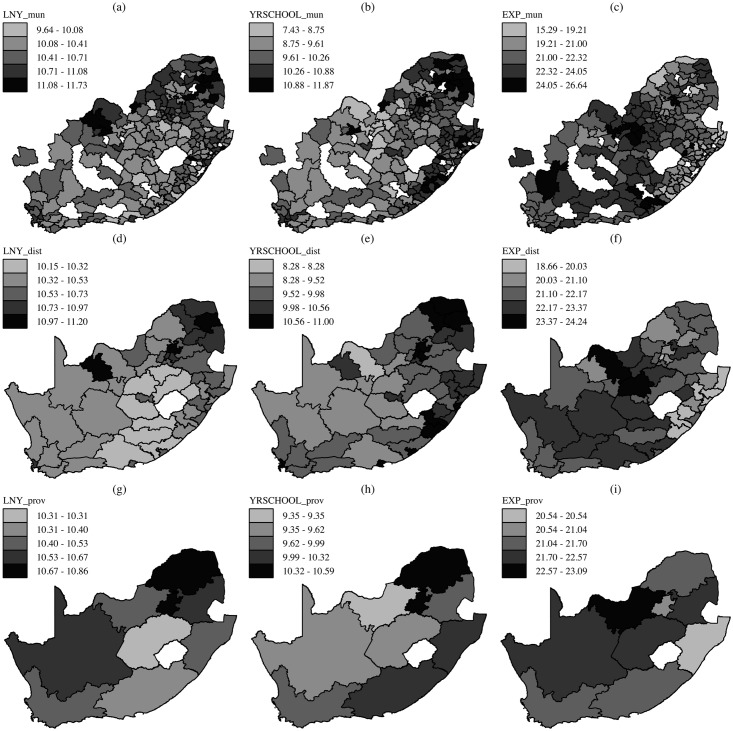
Municipalities: (a), (b) and (c). Districts: (d), (e) and (f). Provinces: (g), (h) and (i).